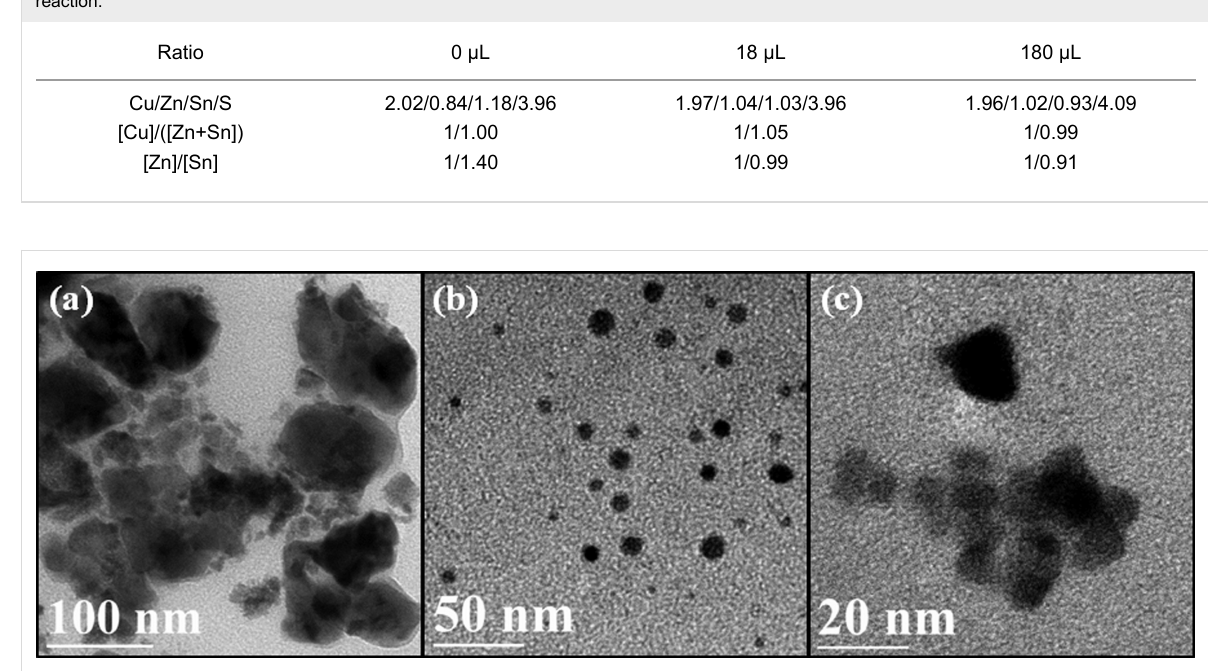
Figure 4: TEM images of CZTS nanocrystals synthesized using (a) 0, (b) 18 and (c) 180 μ L of TGA at 240 °C for 24